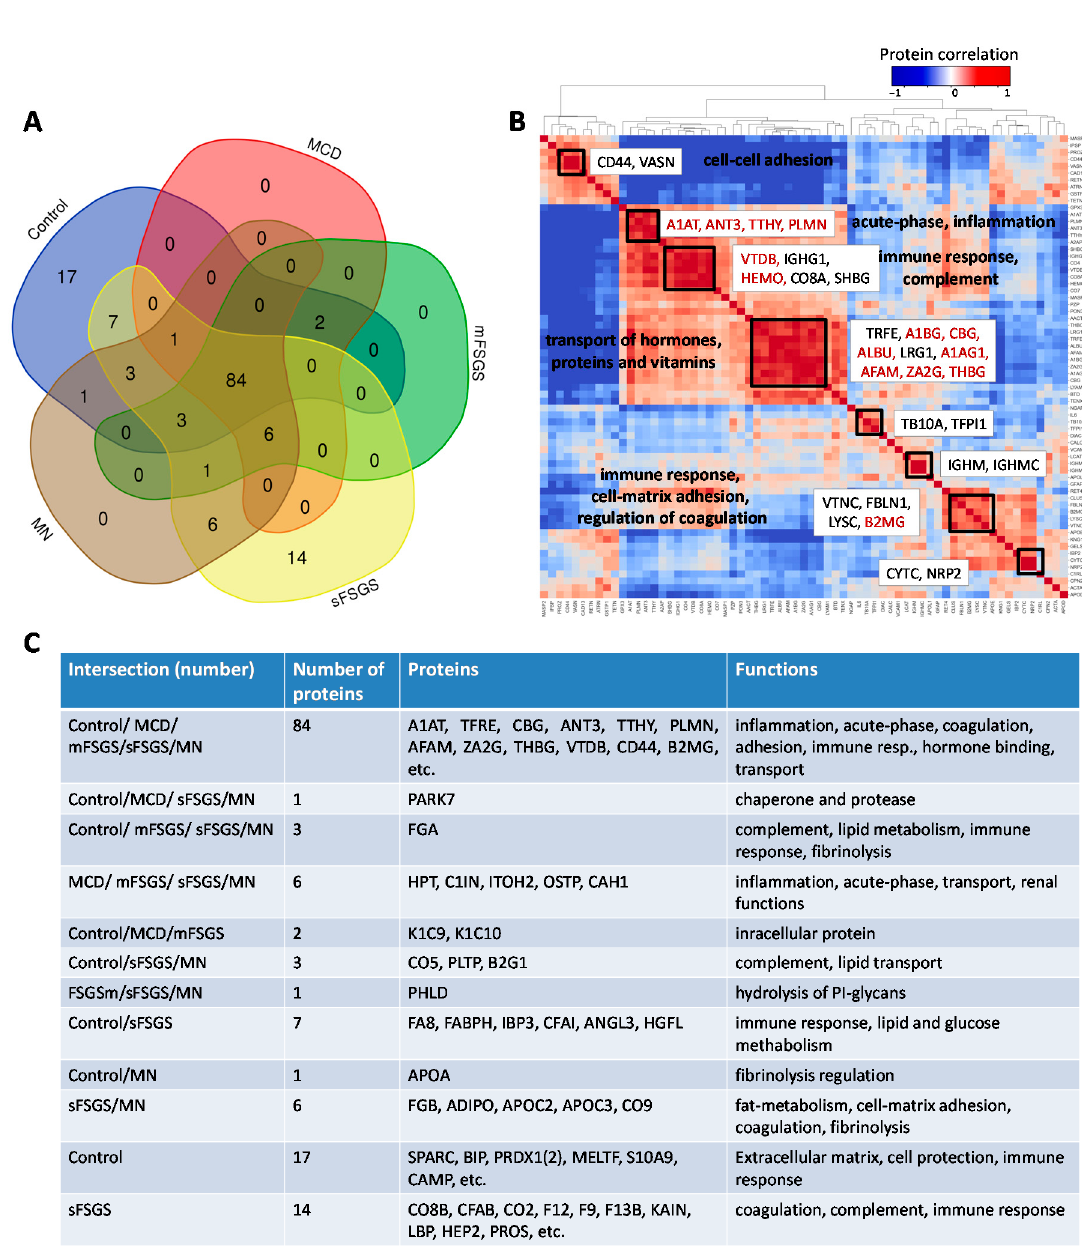
Figure 1. Distribution of 138 proteins from the BAK270 MRM assay that were identified in 69 urine samples from healthy and CKD patients with glomerulopathies: ( A ) Venn diagram for proteins identified in ≥ 2/3 of samples from at least one group of patients. ( B ) Pairwise correlations among the core proteins. ( C ) Description of proteins in accordance with their distribution in the diagram. Abbreviations for core proteins are given in the legend for Table 1; for other abbreviations, see Supplementary Table S1.